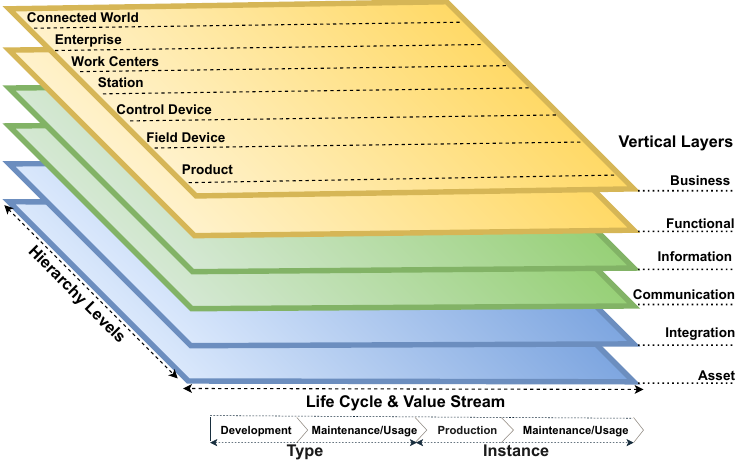
Figure 3. RAMI 4.0 architecture model (adapted from